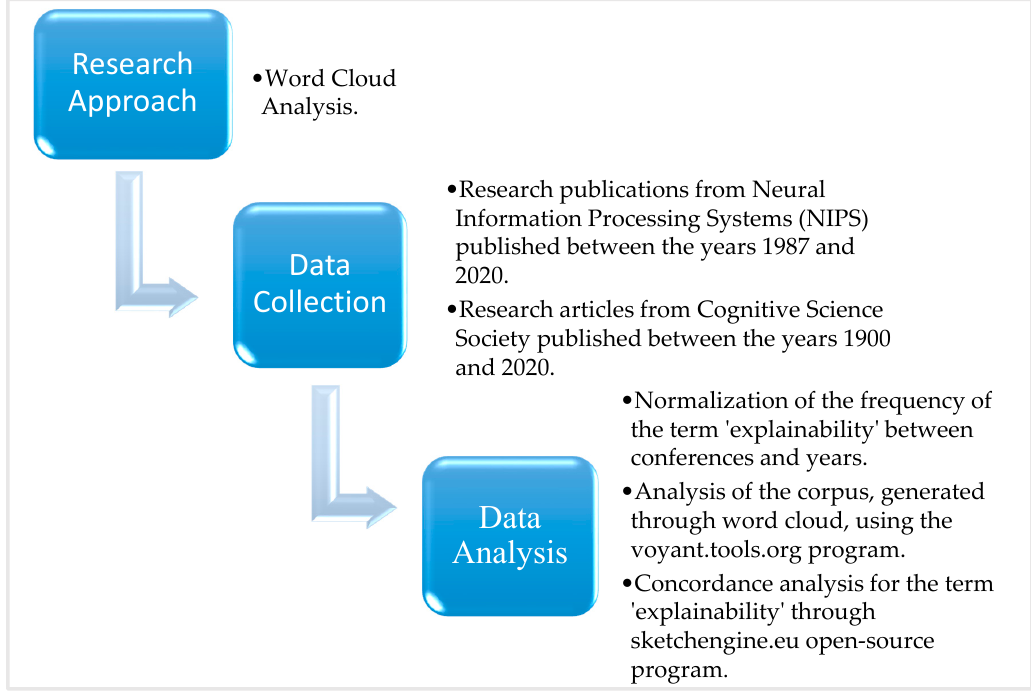
Figure 1. A flowchart of the proposed method .